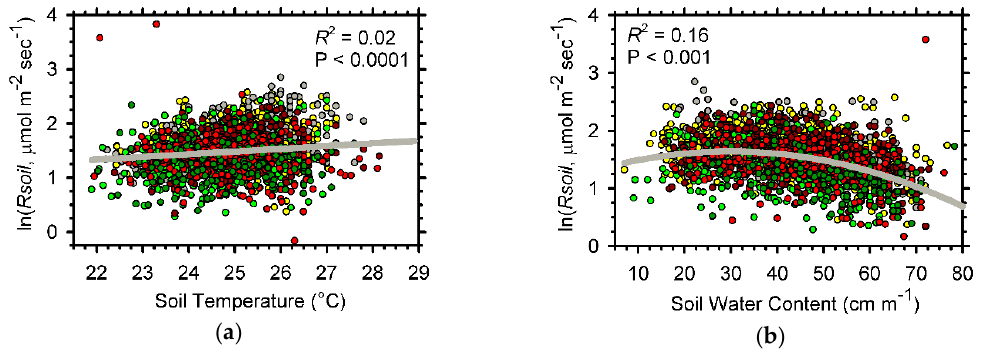
Figure 8. ( a ) The relationship between log (soil respiration), i.e., ln( Rsoil ), and soil temperature at 5 cm depth was highly significant, signifying an exponential relationship between CO 2 emissions and temperature. Colors follow Figure 1; ( b ) The relationship between soil moisture content and soil respiration was non ‐ linear (Equation (3)). Both figures include data from all across ‐ site surveys; every other datum is shown to improve legibility.